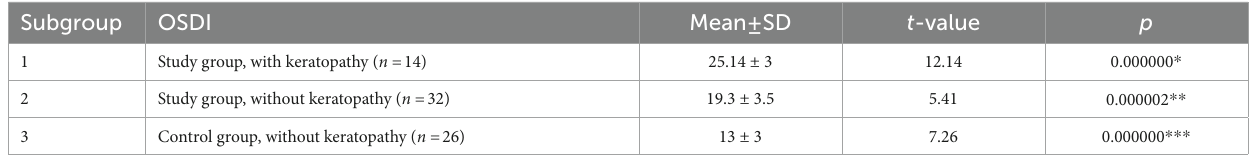
TABLE 3 Impact of keratopathy on OSDI in study and control